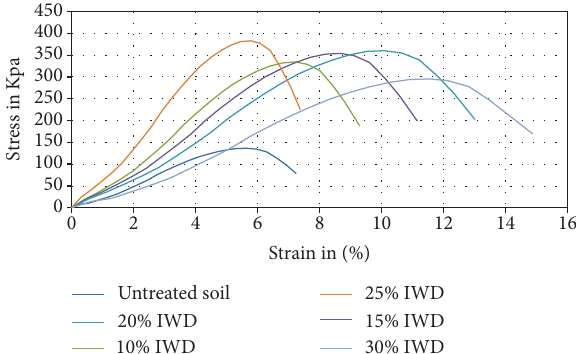
Figure 9: Efect of waste incineration bottom ash variation and 14-day curing time on weak subgrade soil.